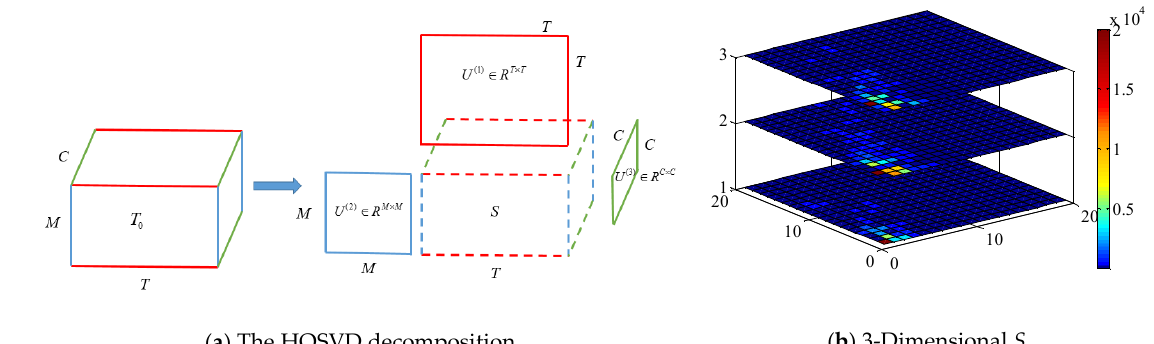
Figure 5. HOSVD-based Image De-noising.